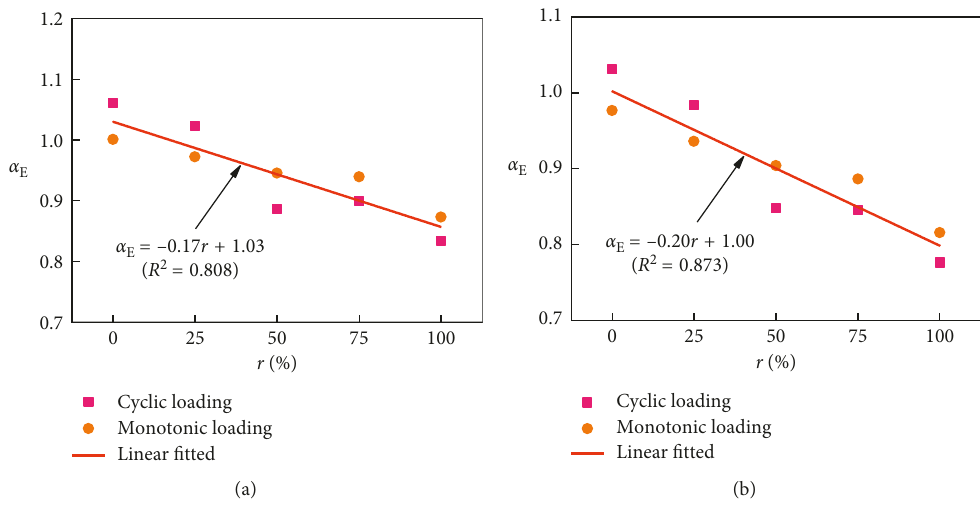
Figure 9: Effect of the RCA replacement percentage on the values of α